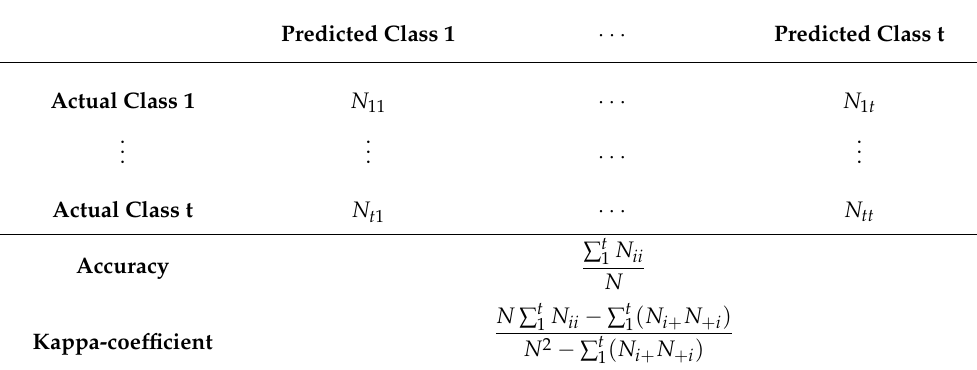
Table 7. Formulas of accuracy and kappa-coefficient.